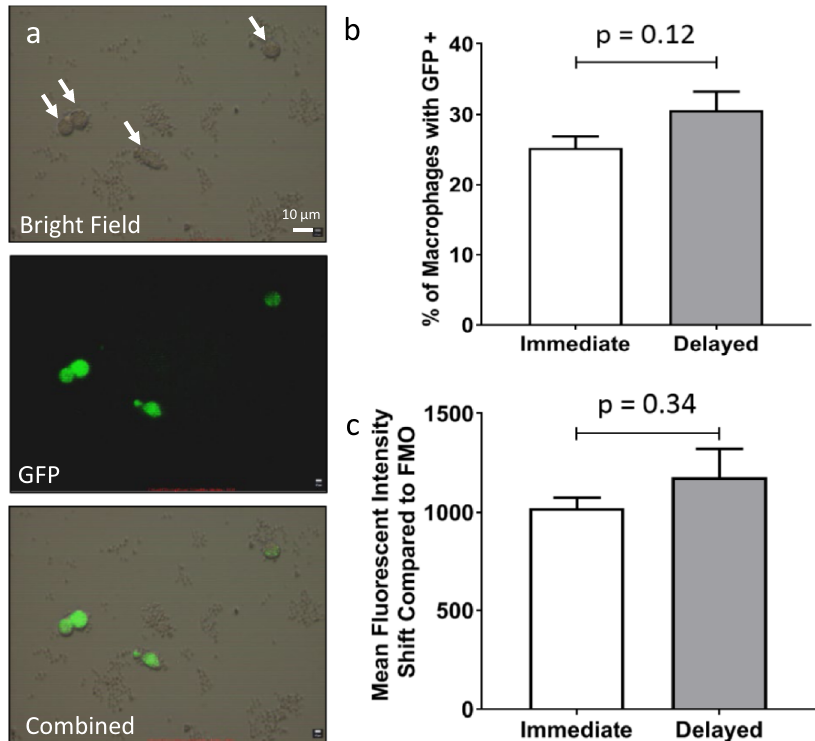
Fig. 4 Delayed repair does not affect macrophage phagocytosis. Fluorescent microscopy indicates the presence of GFP signal after phagocytosis of bioparticles by macrophages ( a ) (white arrows). Macrophage phagocytic function was analyzed by GFP signal generated from phagocytosed bioparticles using FACS. No signi fi cant differences were observed in the percentage of macrophages with positive GFP signal ( b ) or the mean fl uorescent intensity shift ( c ) between macrophages harvested from immediate and delay groups. No signi fi cant difference was observed between male and female animals ( t test at P < 0.05, n = 12/group, 6 males, 6 females).